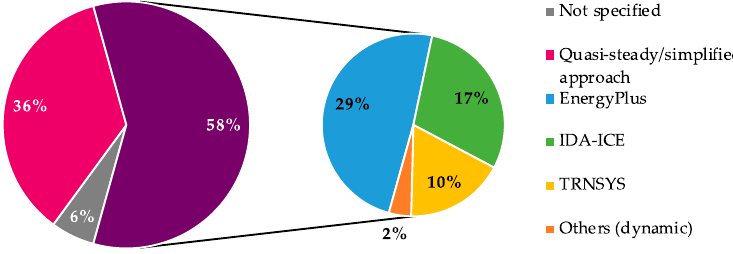
Figure 13. Methods for energy performance calculation: simplified (S) vs. dynamic (D). Repartition of the analyzed papers according to the tool used. Table 3. Number of papers for each combination of methodological approach.